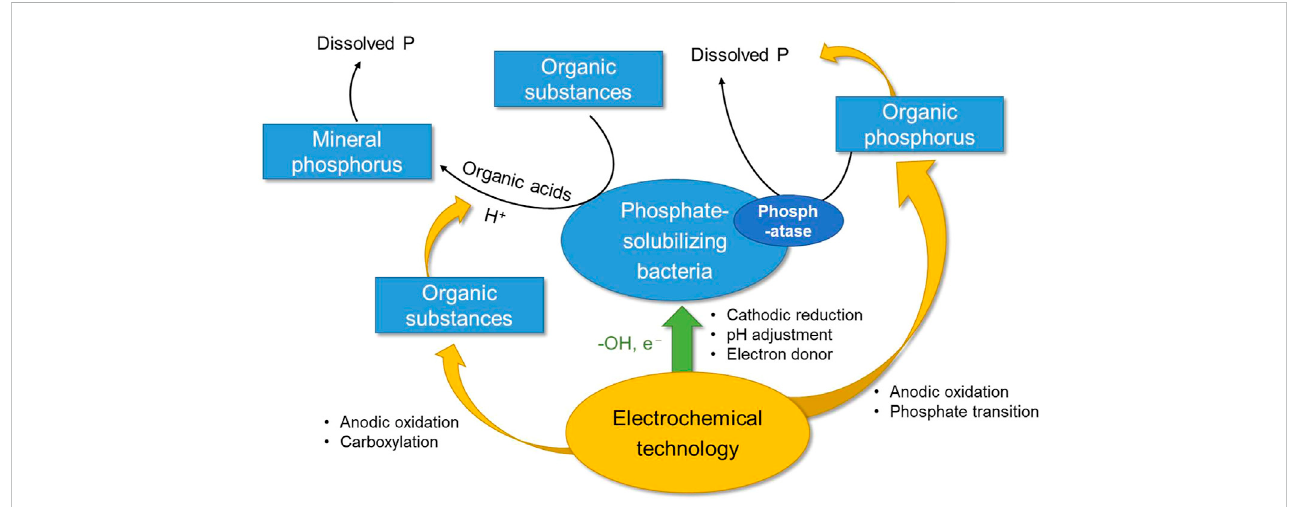
FIGURE 1 Schematic illustration of the electrochemical reduction-oxidation process on the phosphorus solubilization performance conducted by phospholytic bacteria